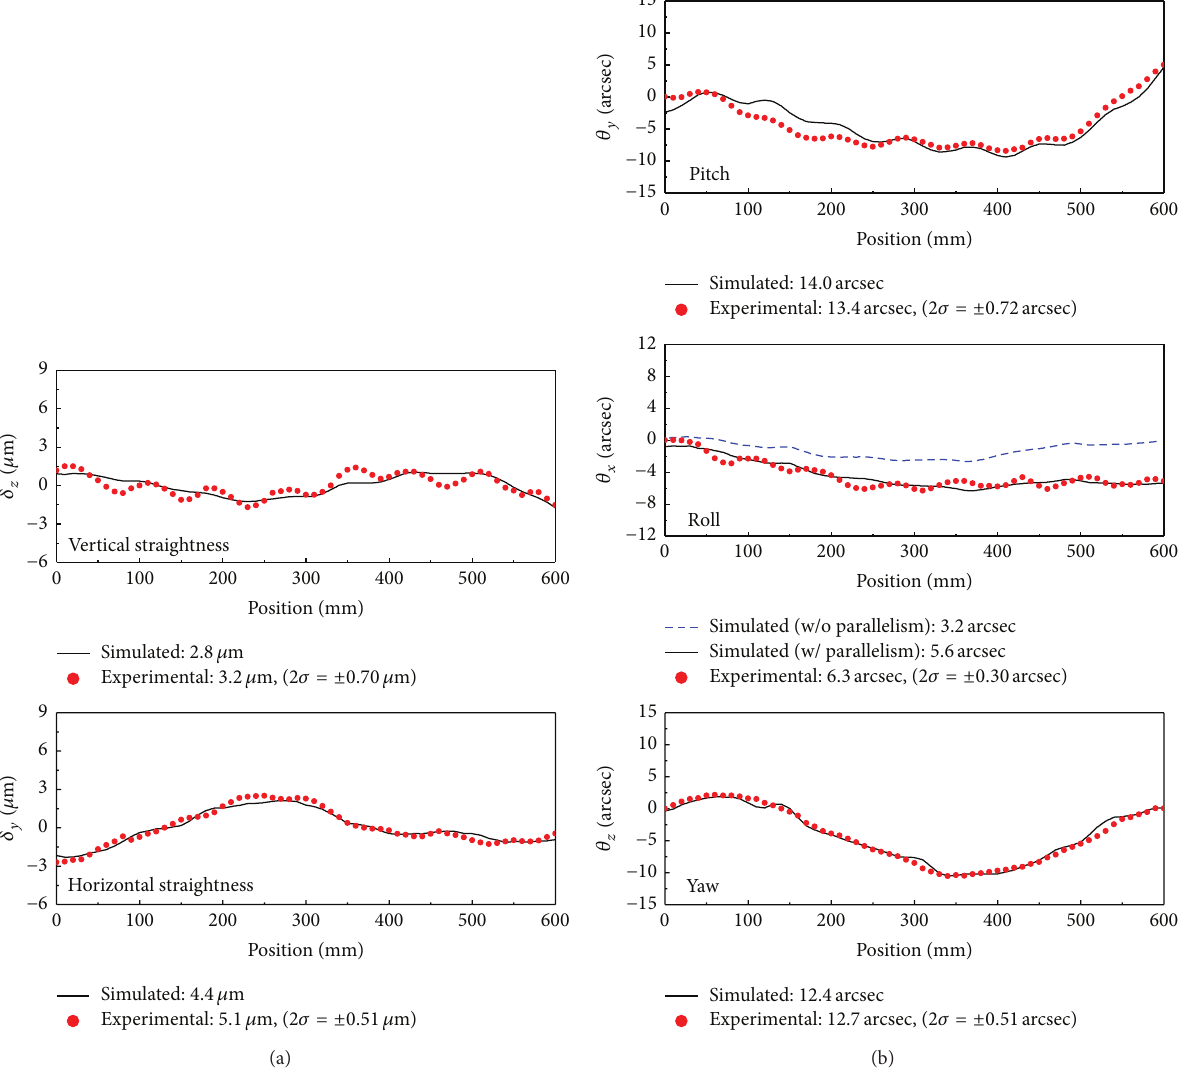
Figure 16: Comparison of calculated and measured data. (a) Linear components of the error and (b) the angular components.